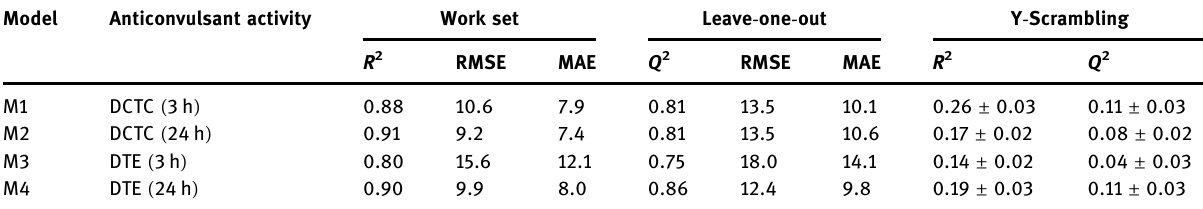
Table 2: The statistical characteristics of 2D QSAR models Model